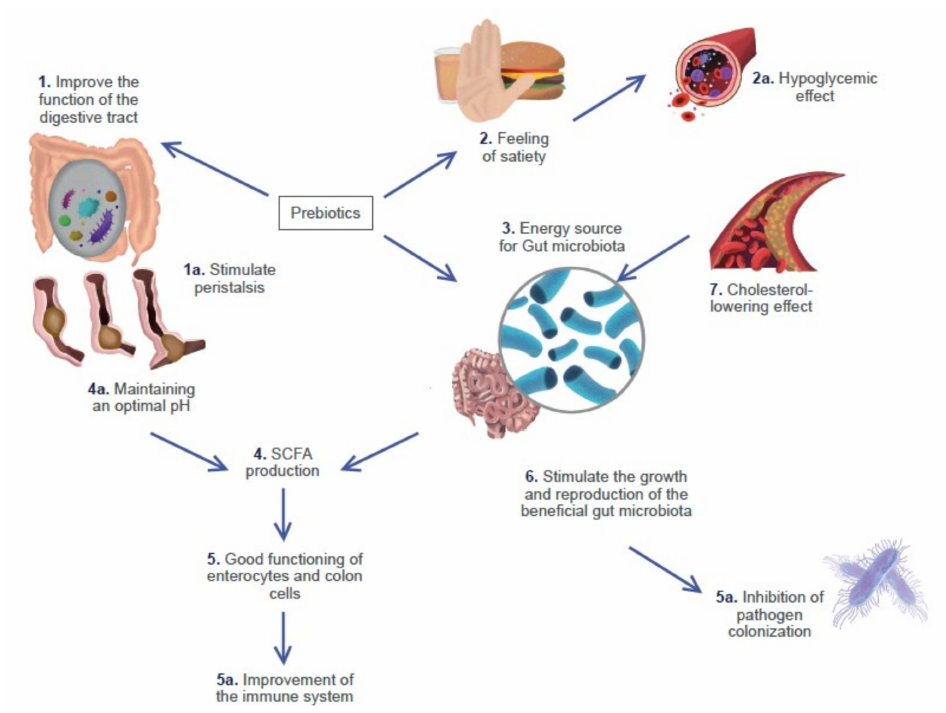
Figure 2. Functions of prebiotics. (1) The regulation of intestinal transit by water retention, which im- proves stool consistency and makes movements more fluid (1a), thereby stimulating peristalsis. (2) In adequate amounts, a feeling of satiety is given. They inhibit the absorption of simple carbohydrates and reduce blood glucose. (3) With a good source of energy, the gut microbiota achieves a proper function. (4) The production of SCFA (4a) has an impact on the intestinal pH (which, under optimal conditions, is slightly acidic), leading to the inhibition of the proliferation of pathogens. (5) SCFAs are a source of energy for enterocytes and colonocytes, (5a) improving the immune system. (6) They stimulate the growth and reproduction of beneficial gut microbiota, (6a) inhibiting the colonization of pathogenic bacteria. (7) The proper function of the gut microbiota induces